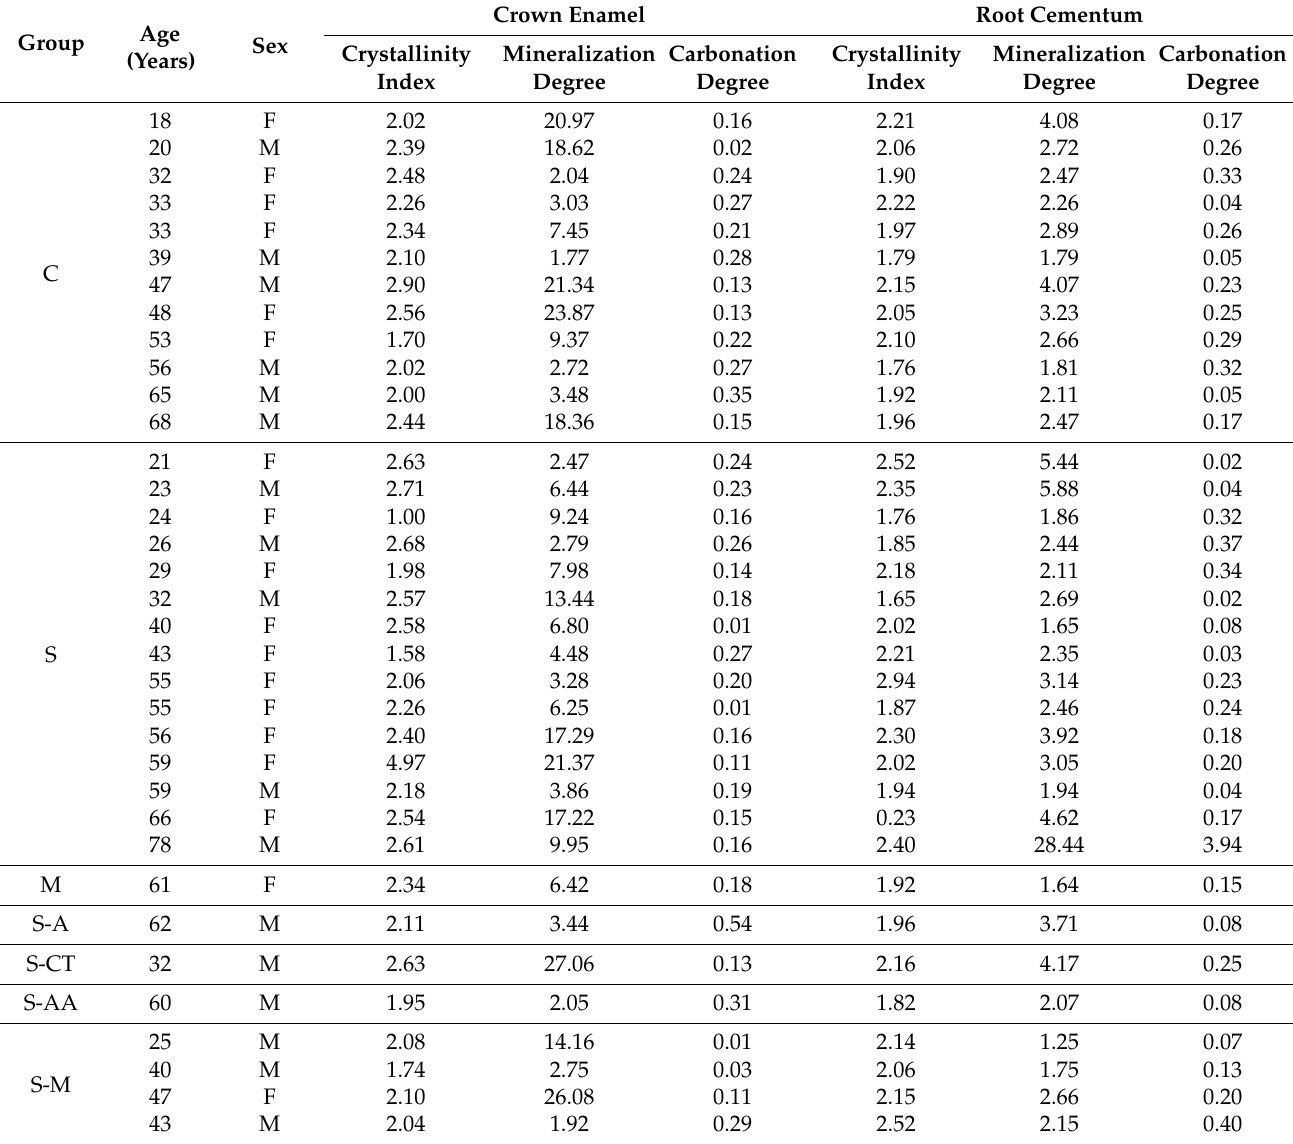
Table 1. Crystallinity index, and degrees of mineralization and